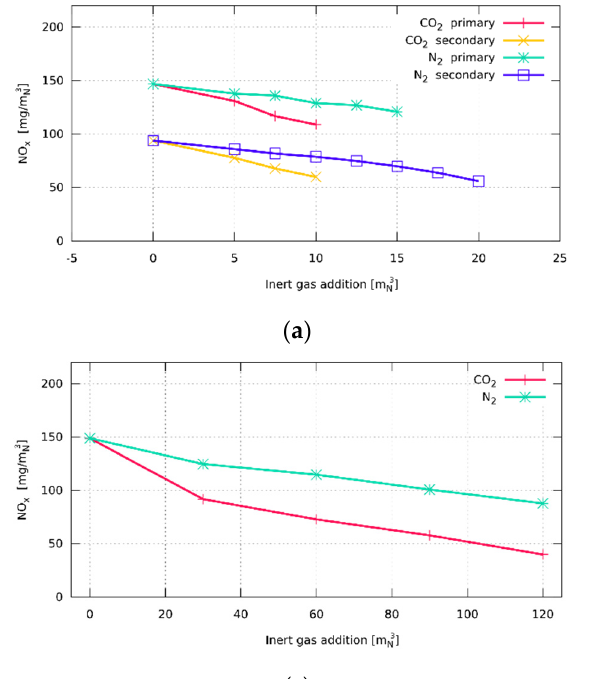
distribution—Burner A; ( b ) burner with staged air distribution—Burner B; ( c ) low-calorific burner— Burner C.